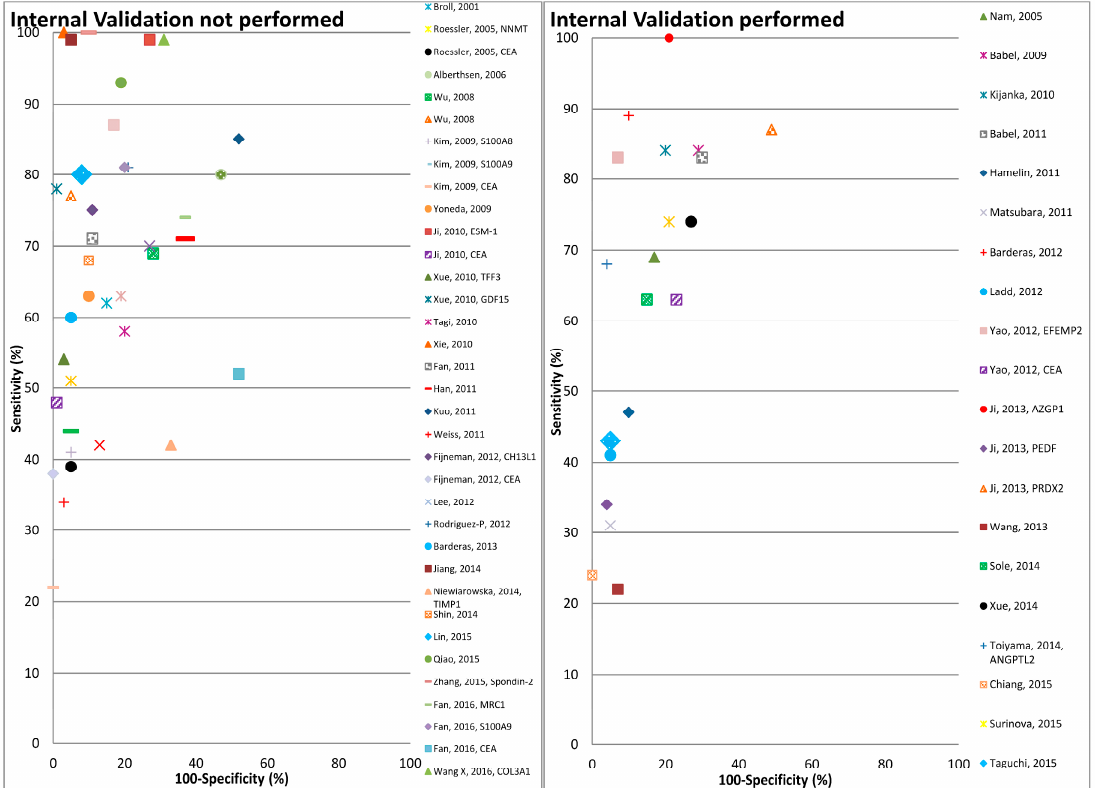
Figure 2. Graphical representation of diagnostic performance of protein markers with respect to internal validation performed by the studies.